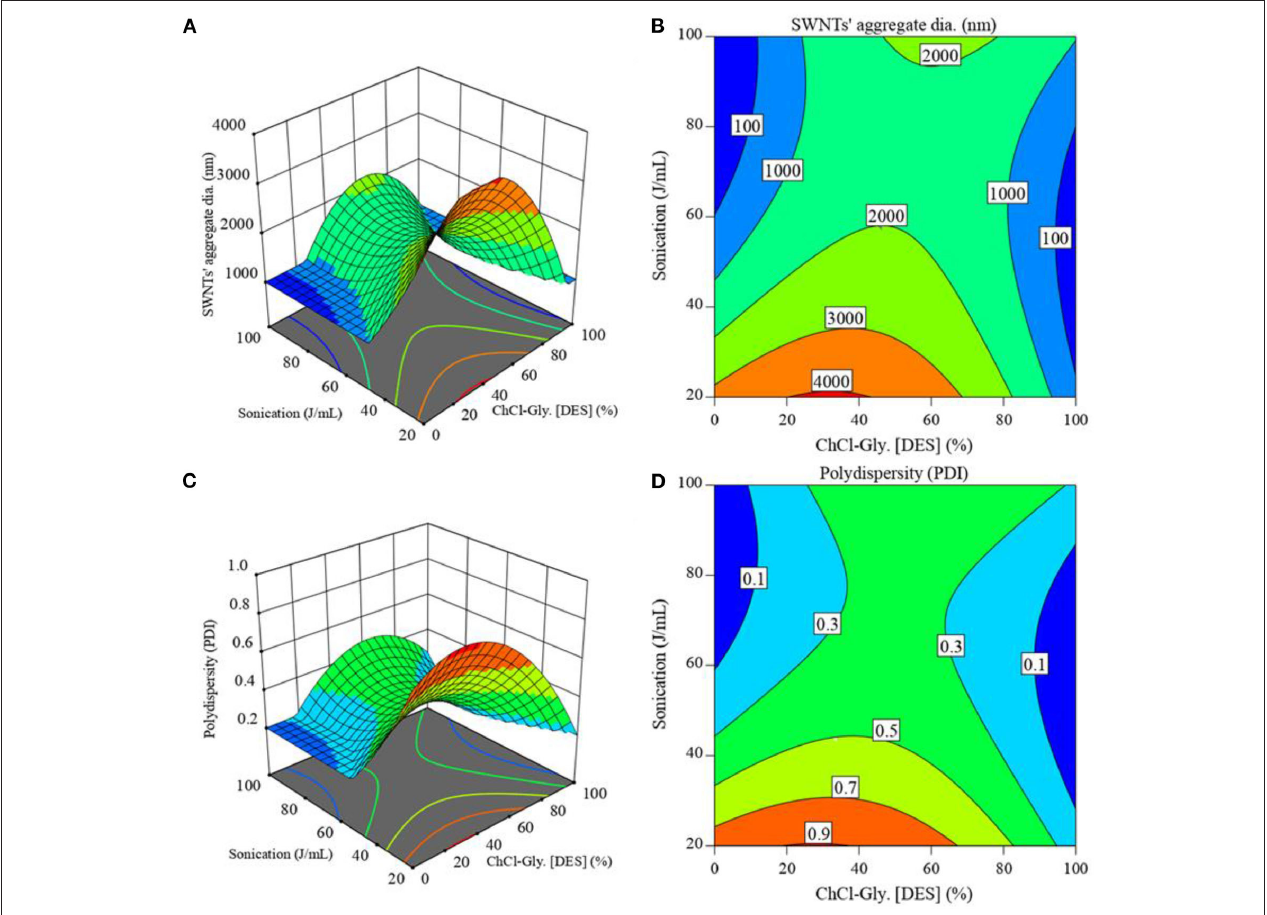
FIGURE 5 | Combined impacts of ChCl-Gly concentration (mass%) and sonication (J/mL) on (A,B) SWNTs’ aggregate diameter (nm) and (C,D) polydispersity (PDI). The SWNTs’ concentration was fixed at 50 mg/L. Conditions for superior dispersion of SWNTs are indicated by low values of aggregate diameter and PDI approaching 0 (both being blue). Ideal performance occurs at very low and high concentrations of the DES, and notably, the DES can achieve high performance at lower sonication energies than the usual solvent, water.